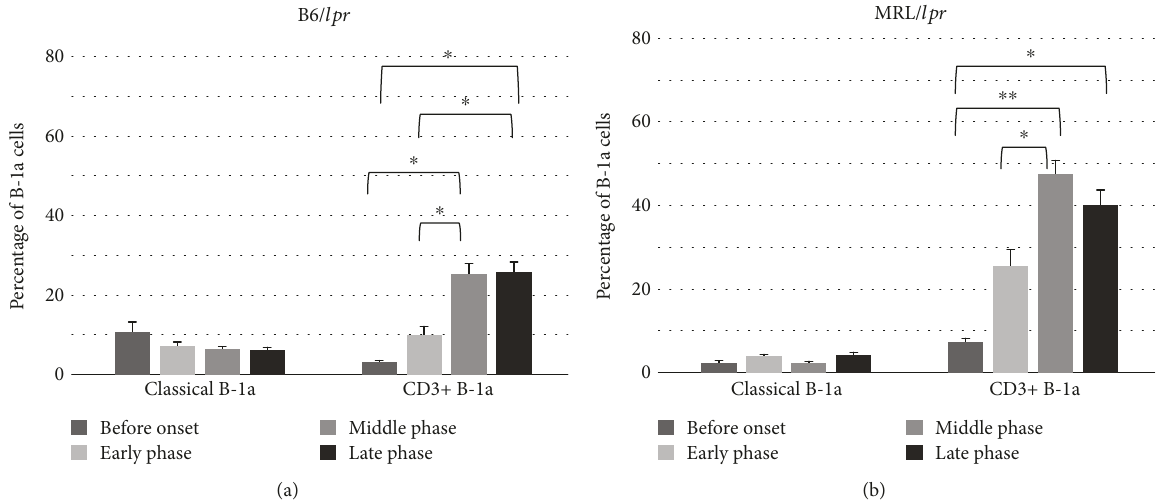
Figure 5: The relative percentage of classical B-1a and CD3+ B-1a cells in the peritoneal cavity. Peritoneal mononuclear cells obtained from the B6/ lpr ( n = 17 ) (a) and MRL/ lpr ( n = 16 ) (b) mice were stained with CD3, B220, CD5, and CD23 antibodies and analyzed using fl ow cytometry.